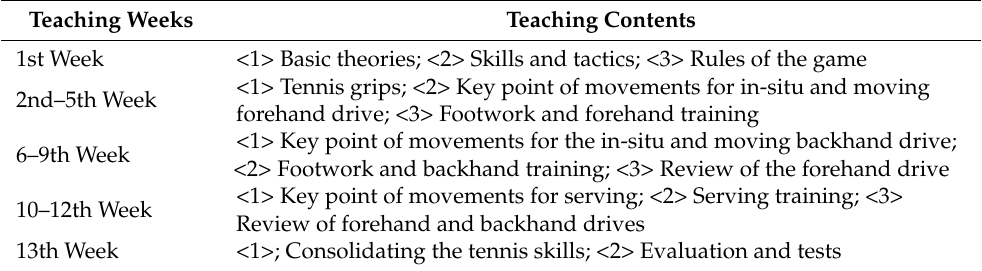
Table 2. Distribution of Experimental Teaching